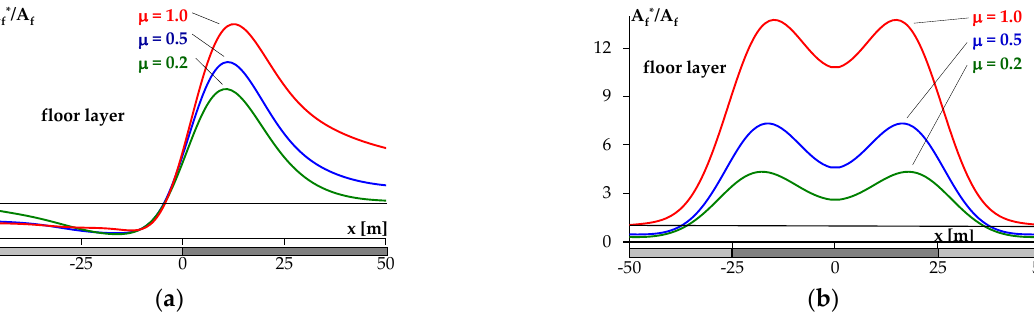
Figure 8. Distribution of the energy concentration coefficient of shear strain for different strain properties of the floor layer in the area of: ( a ) the exploitation edge, ( b ) the residual pillar.